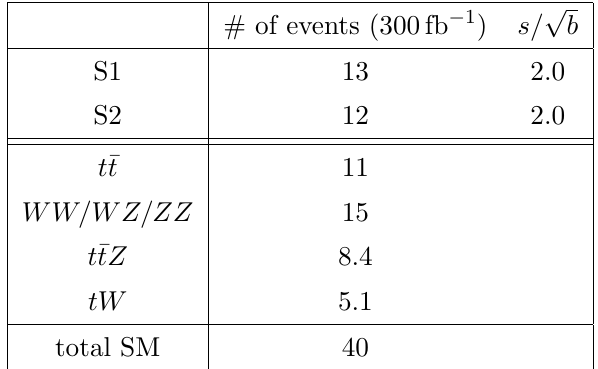
p b after all of the